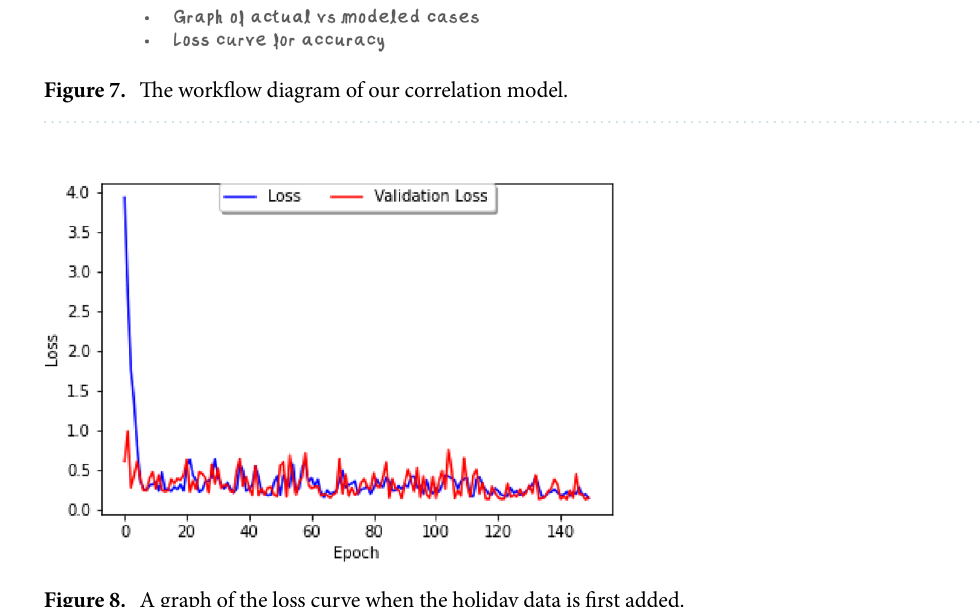
Figure 8. A graph of the loss curve when the holiday data is first